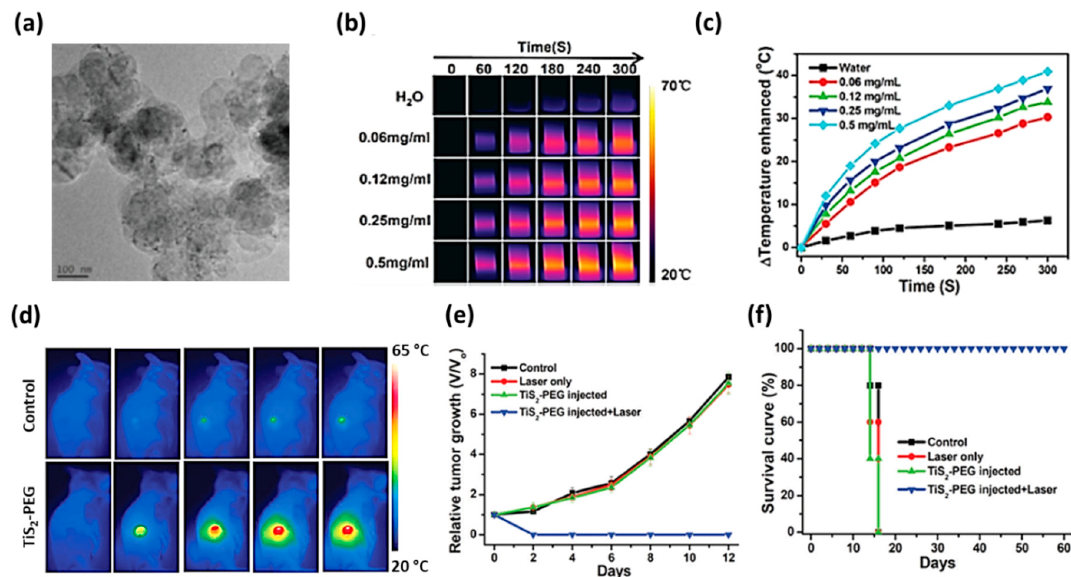
Figure 3. ( a ) TEM image of TiS 2 nanosheets with scale bar 100 nm. IR thermal images ( b ) and photothermal heating curves ( c ) of pure water and TiS 2 -PEG solutions at different concentrations varying from 0.06 mg / mL to 0.5 mg / mL under 808 nm laser irradiation at a power density of 0.8 W / cm 2 . ( d ) IR thermal images of 4T1 tumor-bearing mice after intravenous injection of 200 µ L of TiS 2 -PEG solution (2 mg/mL) at a power density of 0.8 W/cm 2 for 5 min. ( e ) The relative tumor growth of 4T1 tumors and ( f ) the survival curves of different mice groups (control (saline), laser only, TiS 2 -PEG with or without laser) were indicated with standard deviation ( n = 5). Adapted with permission from [37].